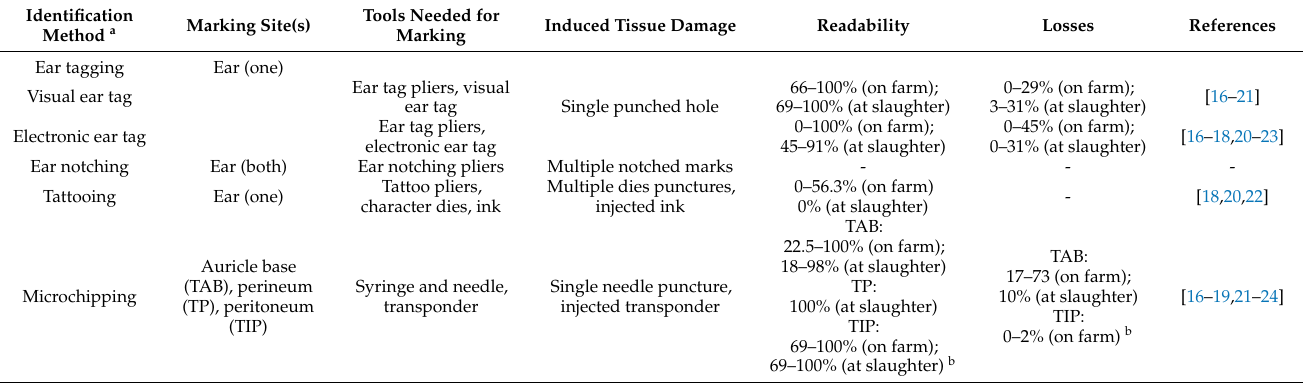
Table 1. Frequently used identification methods for pigs and related tissue damages, readability, and retention rate. For information on other health implications of the respective identification systems and comparisons between techniques, consult Supplementary Table S1. Since the focus of this review is on suckling piglets, several studies investigating the identification of older pigs were excluded here. (TAB = transponder auricle base; TP = transponder perineum; TIP = transponder